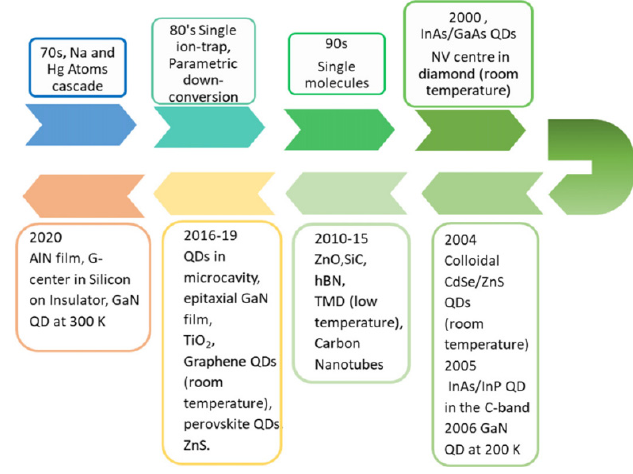
Figure 5. Timeline of SPS development: physical systems and materials [30]. Figure 6d shows an integrated spontaneous parametric down-conversion (SPDC) SPS in GaAs waveguides which sustains two different types of eigenmodes meeting the phase matching condition [29].